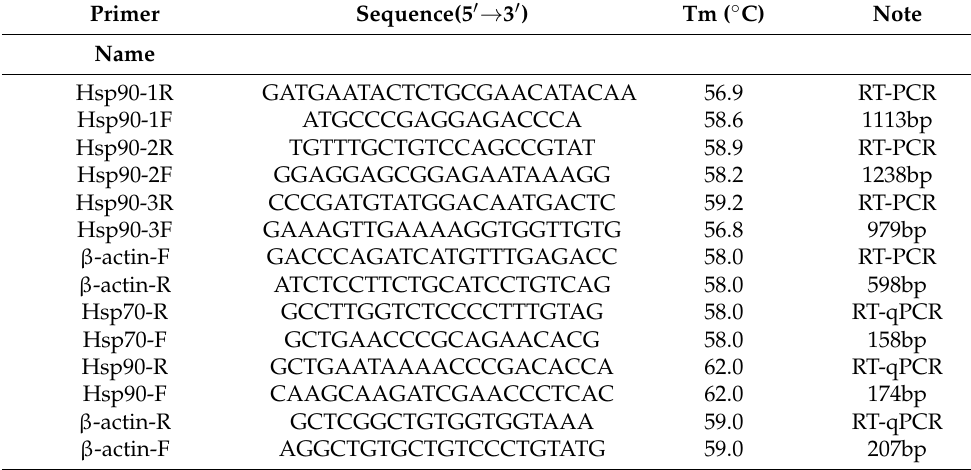
Table 2. Primer sequences of target and house-keeping genes used in the study.